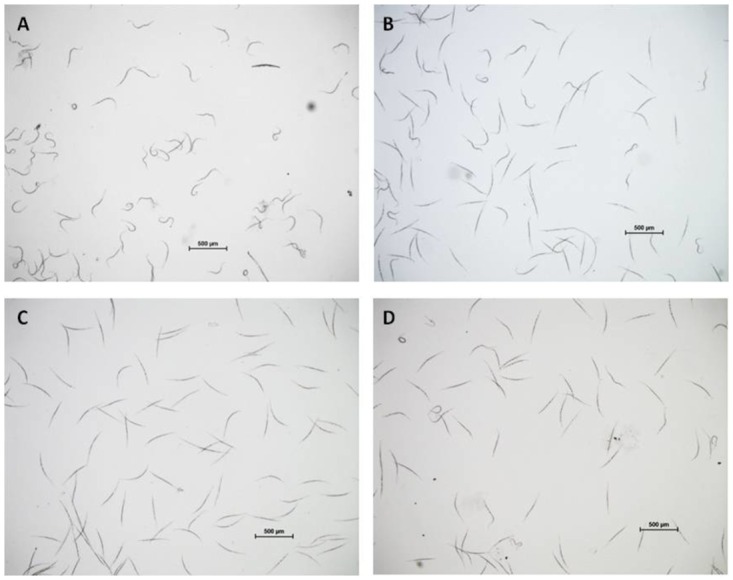
Phenotypes of Meloidogyne javanica J2 following exposure to D. cf. concentrica culture, SVM, and 4-heptanone.The nematodes were exposed to each compound for 48 h at 25°C in the dark, before visualization. A. Control—untreated nematodes. B. Nematodes exposed to three 50-mm-diameter culture plates, each with 5 mL of growth medium, on which D. cf. concentrica had been pre-grown for 4 days. C. Nematodes exposed to SVM preloaded onto 125 mg of perlite particles at 0.25 mL/L (V/V) [3-methyl-1-butanol (0.05 mL, 0.46 mmole), (±)-2-methyl-1-butanol (0.05 mL, 0.46 mmole), 4-heptanone (0.1 mL, 0.72 mmole), and isoamyl acetate (0.05 mL, 0.34 mmole)]. D. Nematodes exposed to 4-heptanone (0.05 mL, 0.36 mmole) preloaded onto 25 mg of perlite particles. The bar represents 500 μm.